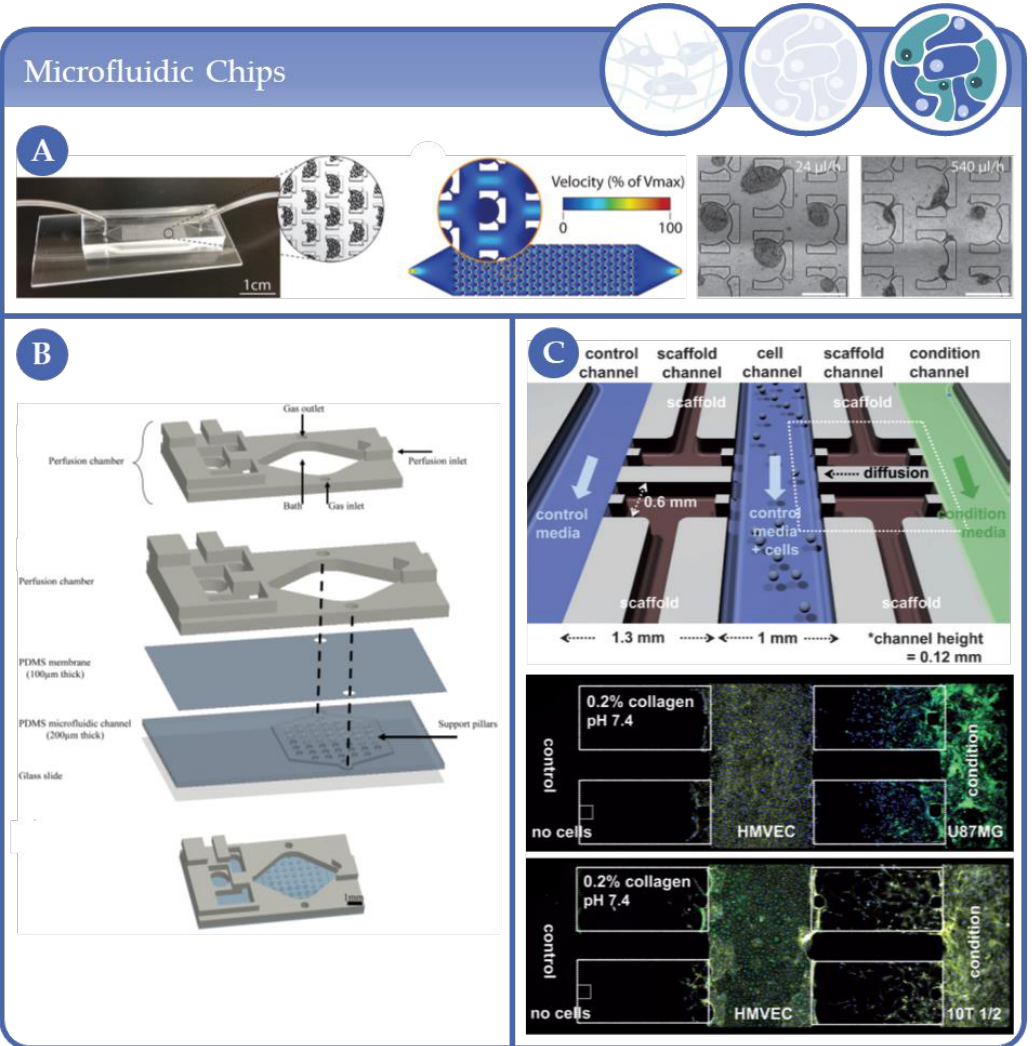
Figure 20. ( A ) Left: U-shaped trap-like features in a patterned PDMS chip for on-chip cultivation and perfusion of cell- aggregates. Center: Simulation of fluid flow through the trap-like features of 500 µm. Right: Aggregates of hepatocytes and 3T3-J3 fibroblasts under perfusion with 24 µL/h respectively 500 µL/h. Republished with permission of the Royal Society of Chemistry from [186] ( B ) Chip of Mauleon et al. for spatial and temporal control of oxygen within brain slices. The sketch displays the modified standard perfusion chamber with a micro-structured PDMS membrane, including sup- port pillars, for oxygen distribution. Reprinted from [189]. ( C ) Schematic illustration of the microfluidic cell migration assay with a control channel (top) and a channel for conditioned media respectively cells (bottom). The microscope images show the application of the chip for the co-cultivation of HMVEC with U87MG respectively 10T1/2 and the resulting migration of the cells into collagen-gels. Republished with permission of the Royal Society of Chemistry from [190].